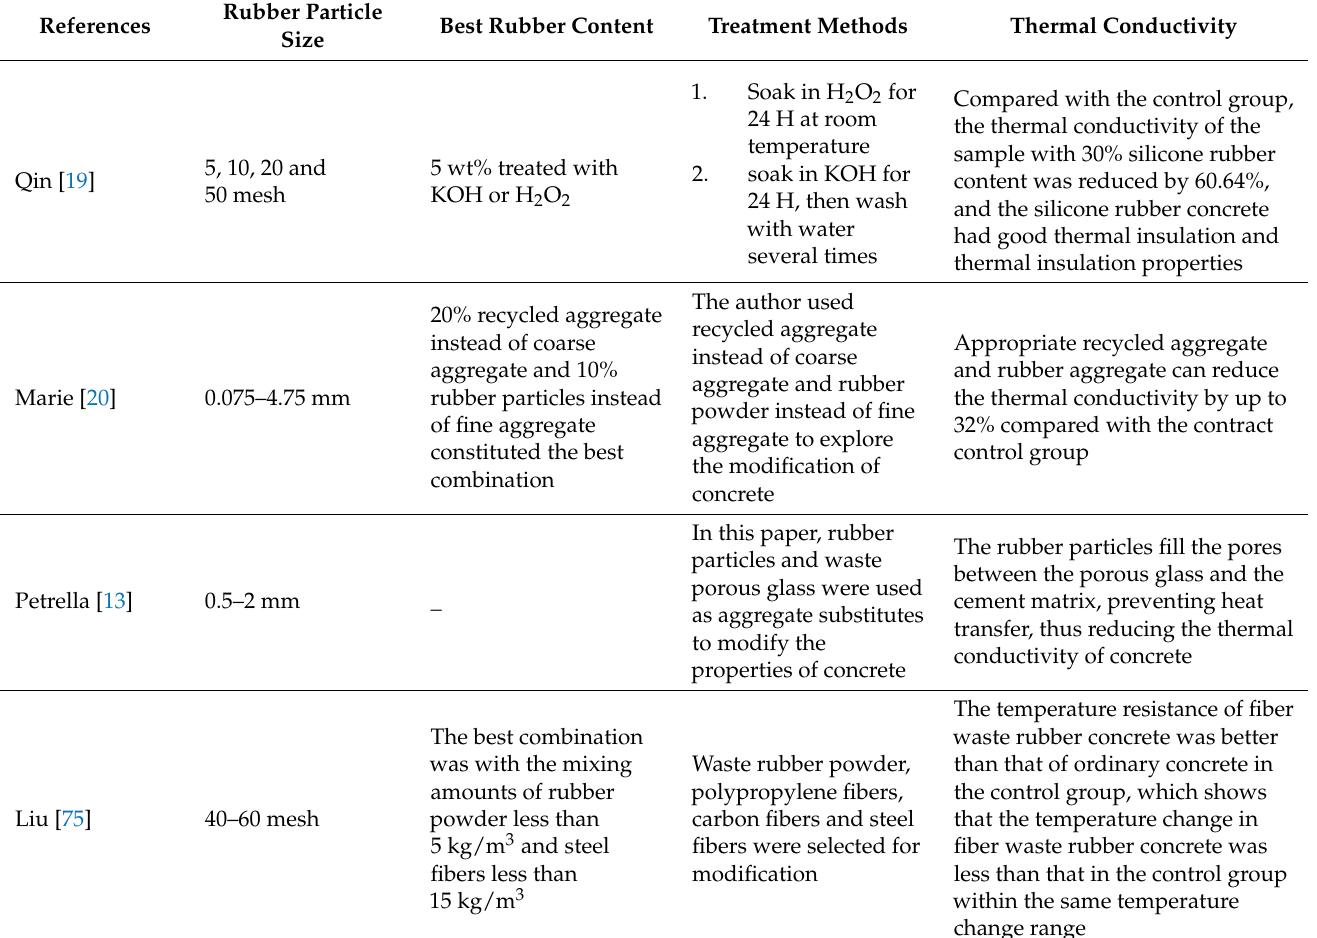
Table 10. Summary table of thermal